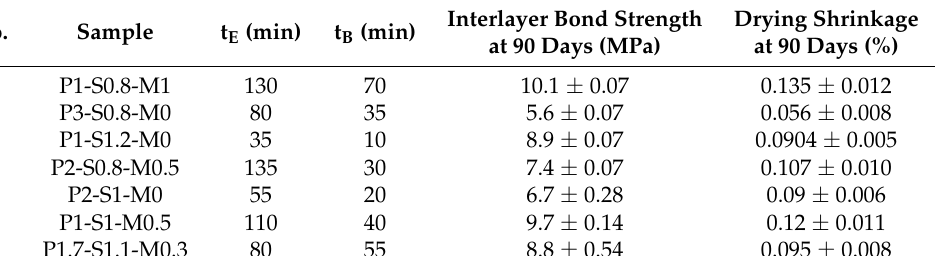
Table 6. The properties of selected samples according to the simplex centroid design method.